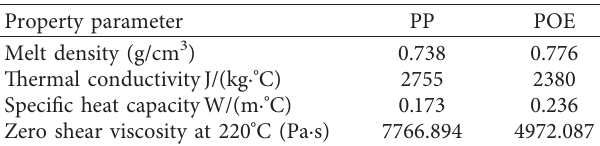
Figure 7: Blend components: (a) polypropylene (PP); (b) polyolefin elastomer (POE). Table 1: Mechanical, thermal, and rheological properties of PP and POE.